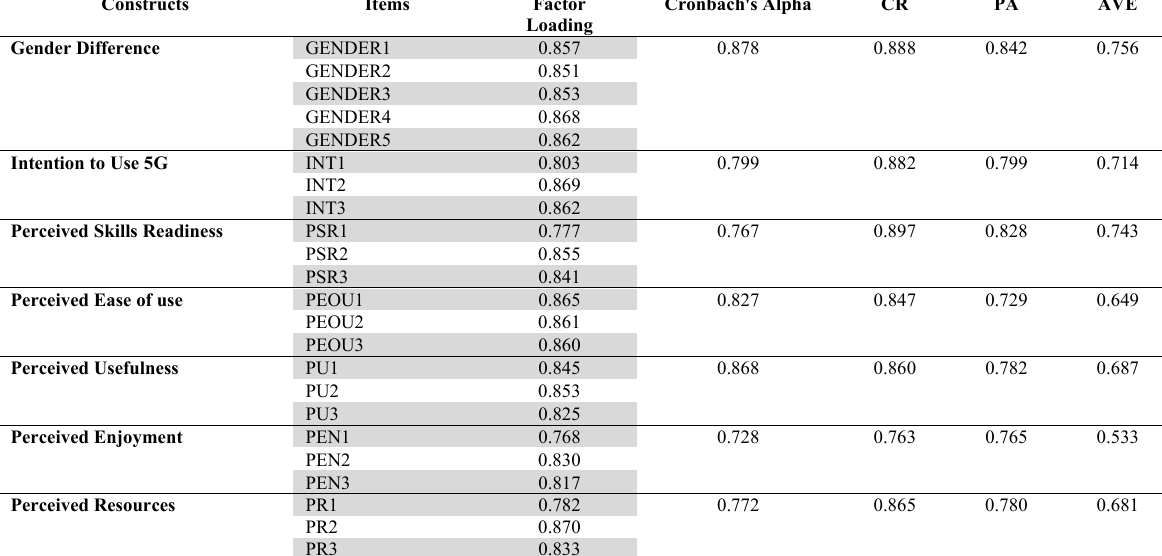
Convergent validity results which assure acceptable values (Factor loading, Cronbach’s Alpha, composite reliability, Dijks- tra-Henseler's rho ≥ 0.70 & AVE > 0.5)